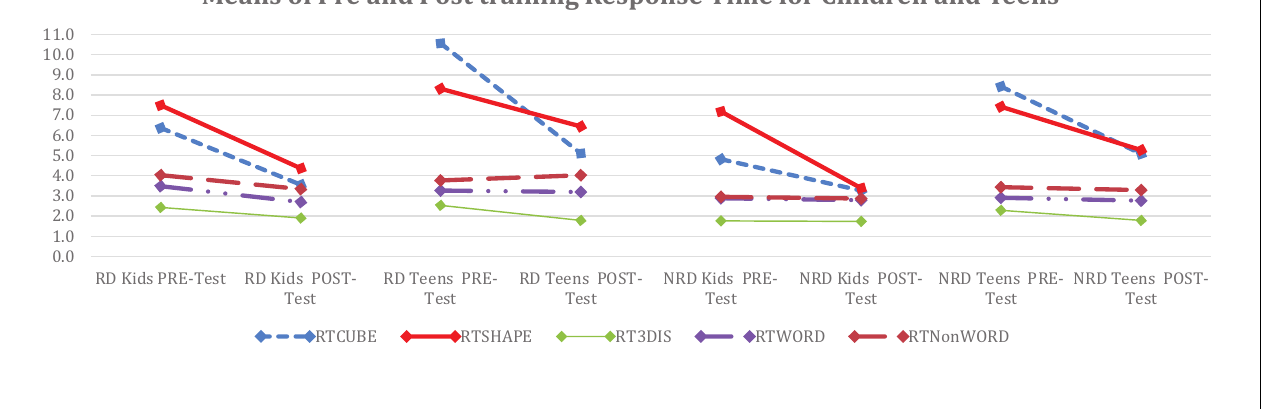
FIGURE 3 | (A,B) Pre- and post-training means of NLB and LB tasks accuracy and RT in RD and nRDs children and teens. Group mean comparisons were used as well as ANOVAs for the analyses, significance was evaluated at.